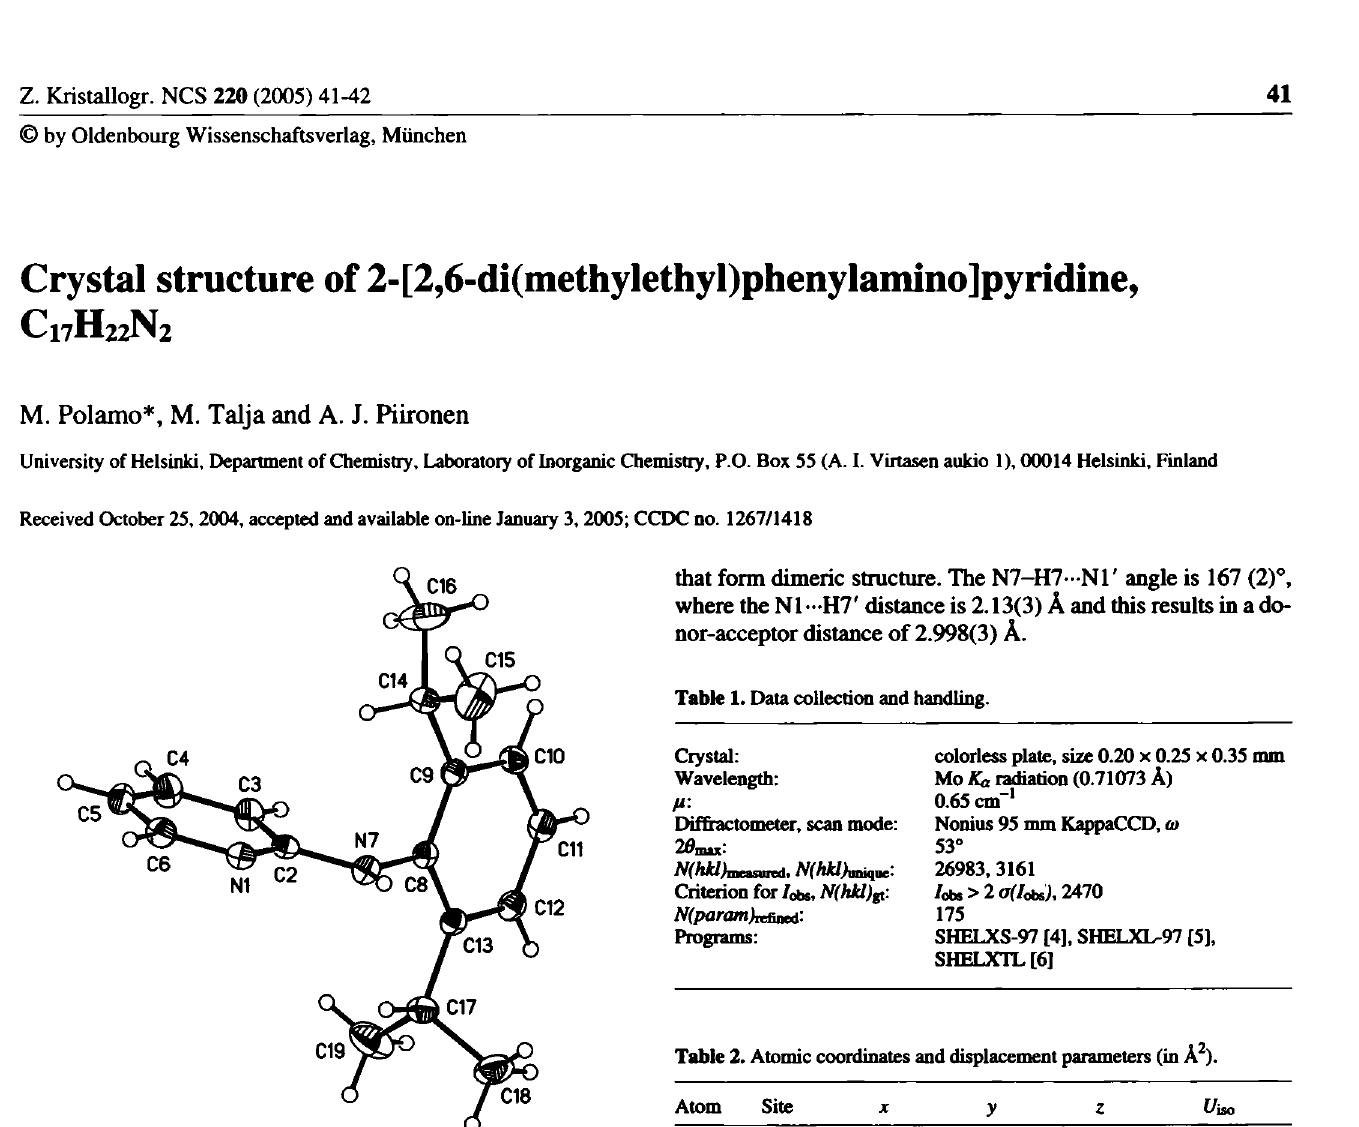
Table 2. Atomic coordinates and displacement parameters (in A 2 ).